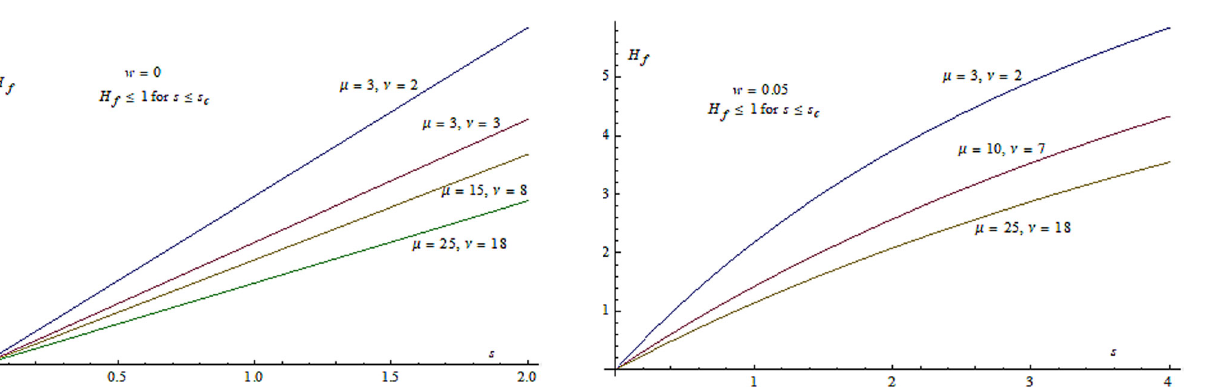
Fig. 6 Behavior of the extended Hod function H f ( x c , s ) for w = 0 for various values of μ and ν . We display the critical values for the reader to verify that the function truly embodies the hoop conjecture. The values are: x c = 1 . 414 , s c = 0 . 3839 ( μ = 3 ,ν = 2); x c = 1 . 2599 , s c = 0 . 5291 ( μ = 3 ,ν = 3); x c = 1 . 3908 , s c = 0 . 6317 ( μ = 15 ,ν = 8); x c = 1 . 931 , s c = 0 . 7919 ( μ = 25 ,ν = 18)